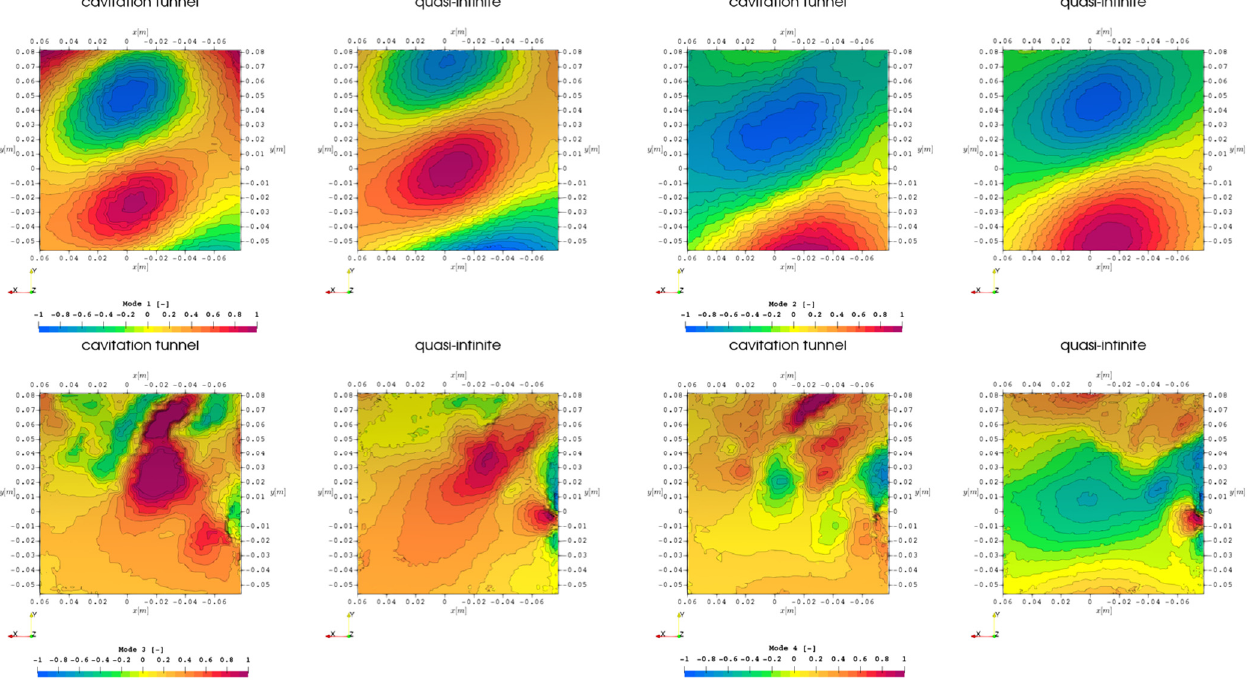
Figure 12. First 4 POD modes of pressure time data set on hull above propeller, comparison of domain extent, LES with cavitation.